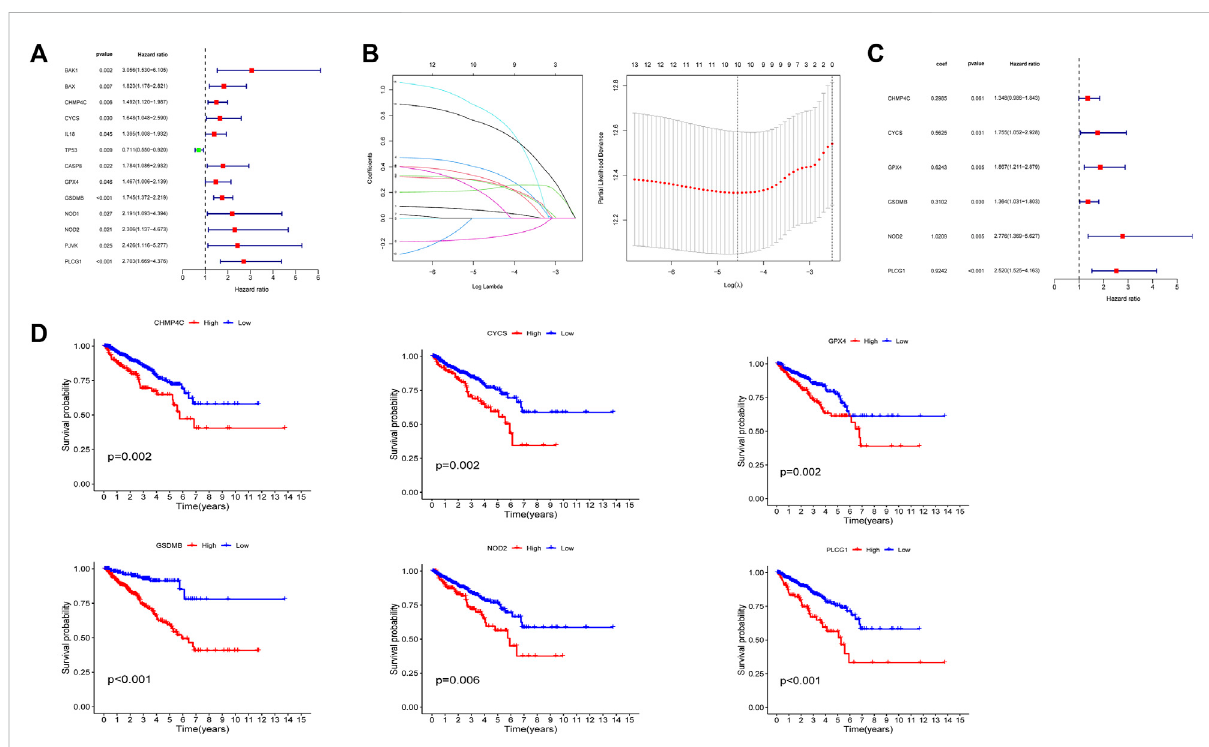
FIGURE 2 Identi fi cation and prognosticanalysis of 6 hub genes. (A) 13 prognostic PRGs obtained by univariate Cox regression analysis. (B) LASSO analysis of13 prognostic PRGs. (C) Therisk coef fi cientsfor 6hub PRGsobtained bymultivariateCox regressionanalysis. (D) The KMsurvival analysis of 6hub